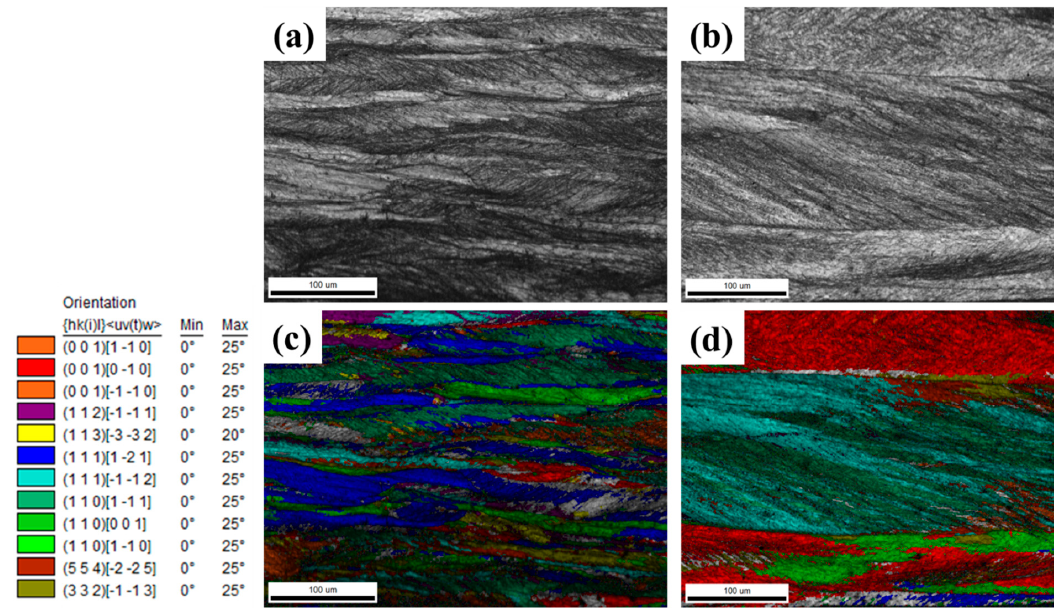
Figure 10. IQ ( a,b ) and orientation maps ( c,d ) for samples annealed at 710 ( a,c ) and 740 °C ( b,d ) and cold rolled to a 72% reduction in thickness.